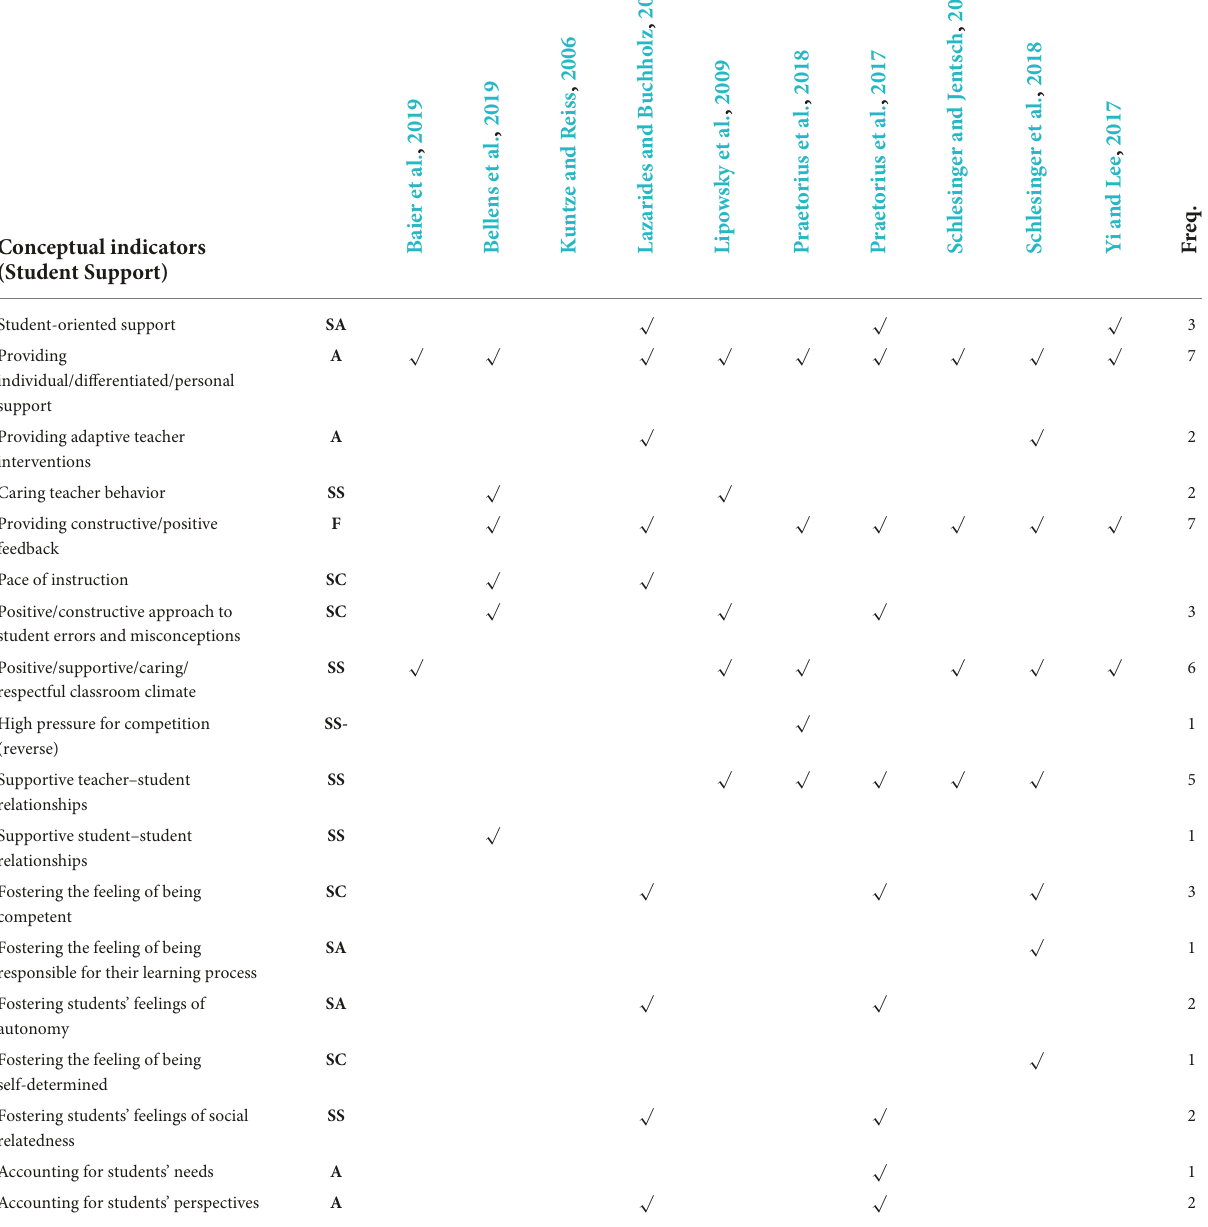
TABLE 4 Overview of conceptual indicators of Student Support described by various conceptual definitions in previous studies.